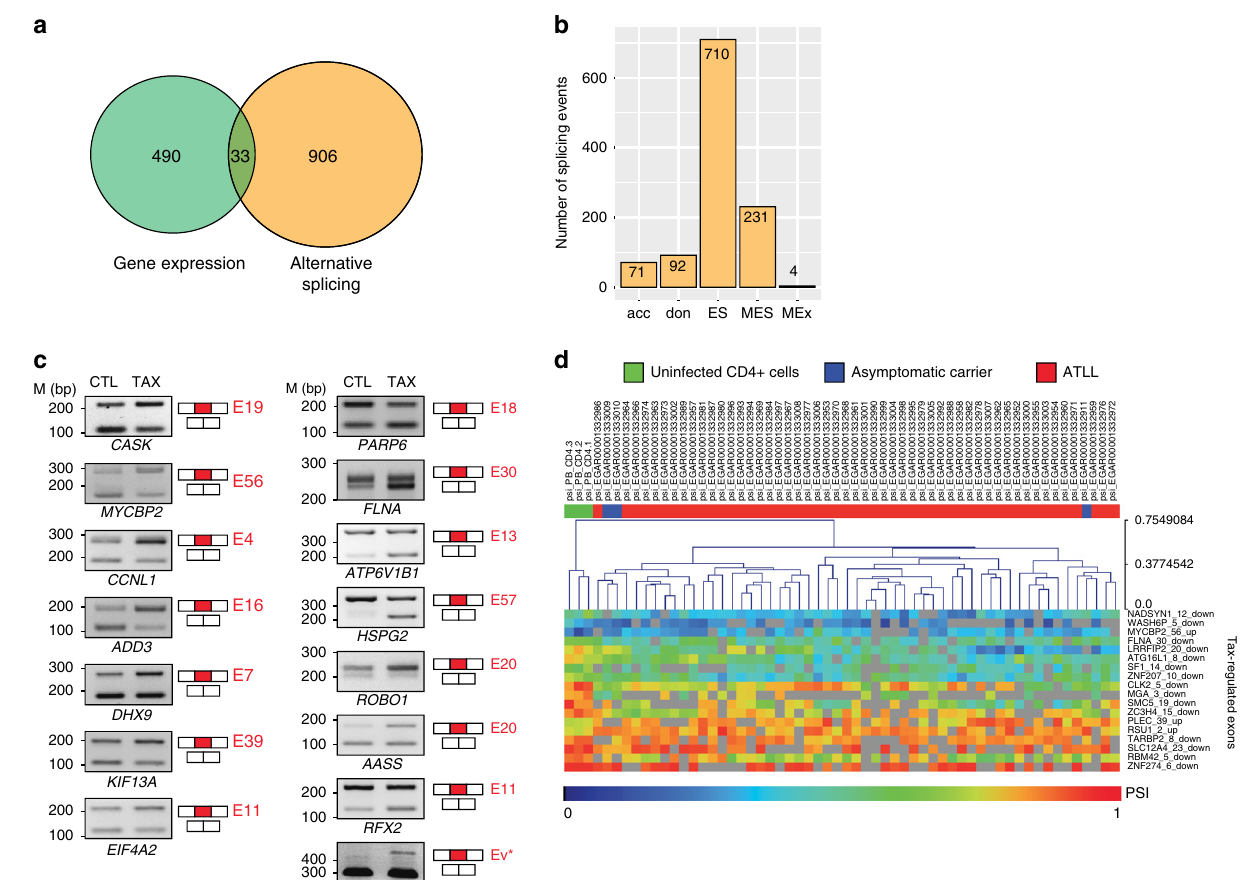
Fig. 1 Tax induces alternative splicing modi fi cations independently of its transcriptional effects. a Genes regulated at the steady-state expression level and at the splicing level upon Tax expression in HEK cells. The signi fi cance thresholds were typically set to 10% for Δ PSI (differential percentage of spliced- in sequence) and 0.6 for log2-gene expression changes ( p < 0.05, Fisher ’ s exact test), respectively. b Different alternative splicing events induced by Tax: alternative acceptor (acc), alternative donor (don), exon skipping (ES), multi-exon skipping (MES), and multi-exclusive exon skipping (MEx). c Validation of alternative splicing predictions by RT-PCR (using 35 cycles). The exon number is indicated in red. CD44 full variants (Ev*) were assessed using primers C13 and C12A (Supplementary Fig. 5). Representative image from three independent experiments is shown. d Exon-based hierarchical clustering. Kruskal – Wallis ANOVA ( p < 0.05) was carried out with Mev4.0 software (http://www.tm4.org/) using the PSI values of exons that share similar regulations upon Tax and in clinical samples (EGAS00001001296). Only the most signi fi cant exon regulations are presented. Source data are provided as a Source Data fi